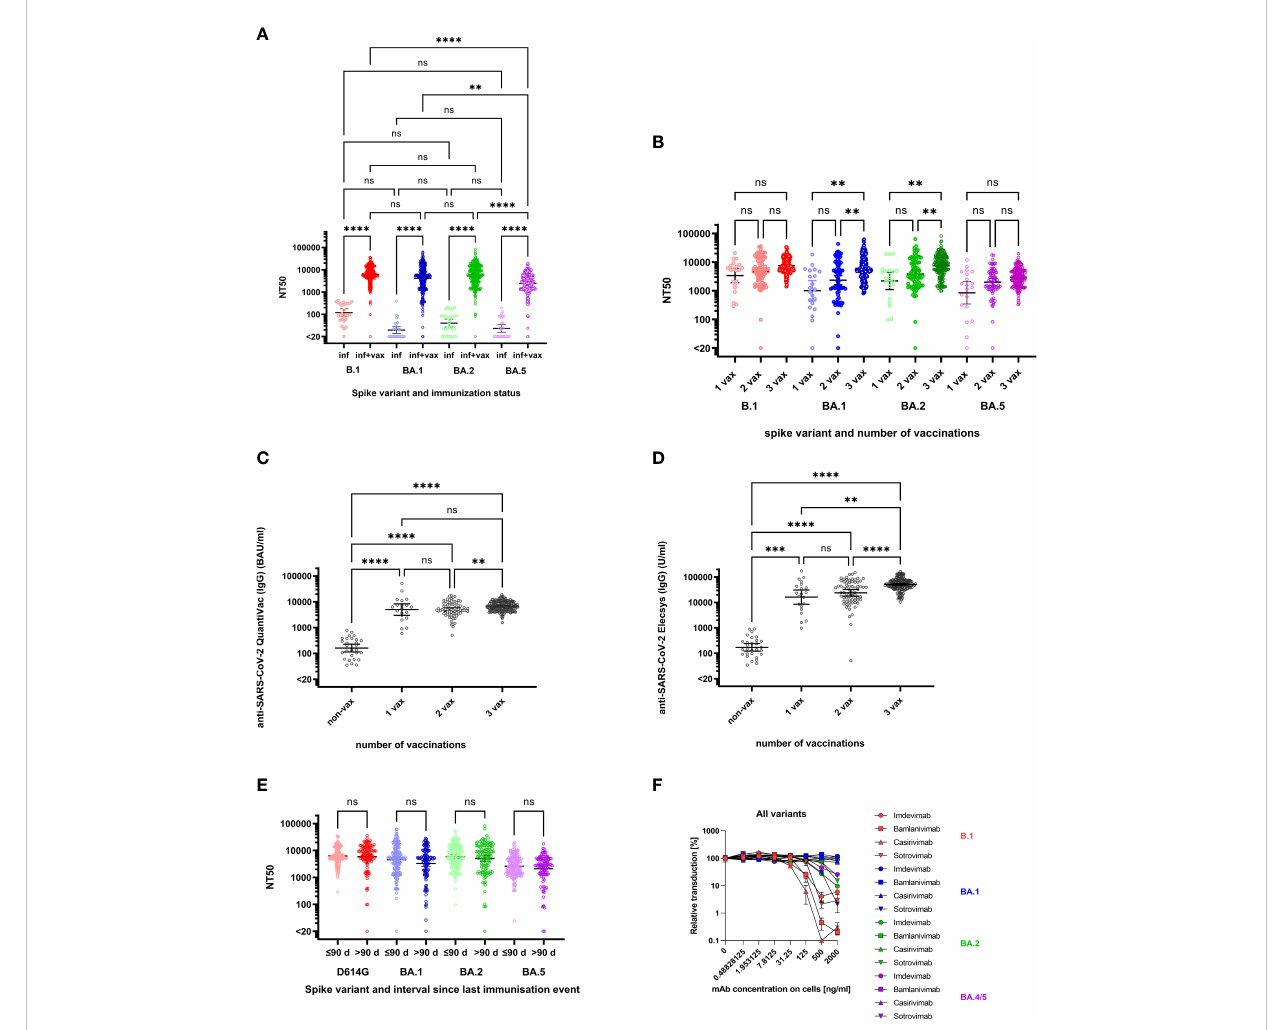
FIGURE 1 Neutralization of Spike variants by convalescent sera and monoclonal antibodies. (A) NT50 against B.1 (red symbols), BA.1 (blue symbols), BA.2 (green symbols) and BA.5 (purple symbols) for individuals with a history of infection (inf, lighter colors) (n=25) and history of infection and vaccination (inf + vax, darker colors) (n=130). The geometric means of NT50 were as follows: against B.1 (inf) 118.4, B.1 (inf+vax) 6247, BA.1 (inf) 19.56, BA.1 (inf+vax) 4122, BA.2 (inf) 40.41, BA.2 (inf+vax) 5709, BA.5 (inf) 23.24 and against BA.5 (inf+vax) 2449. Neutralization of Omicron sublineages BA.1, BA.2 and BA.5 was observed in 51.7%, 24.1% and 51.7% resp., of convalescent individuals without vaccination. In contrast, 99.3% of the sera of superimmunised individuals (vaccinated convalescents) neutralized the Omicron subvariants BA.1 and BA.5 and 99.6% neutralized BA.2. (B) NT50 against B.1 (red), BA.1 (blue), BA.2 (green) and BA.5 (purple) for vaccinated, convalescent donors strati fi ed by number of vaccination doses: 1 vaccination dose (1 vax, lighter colors) (n=19), 2 vaccination doses (2 vax, medium light colors) (n=41) and 3 vaccination doses (3 vax, darker colors) (n=71). The geometric means